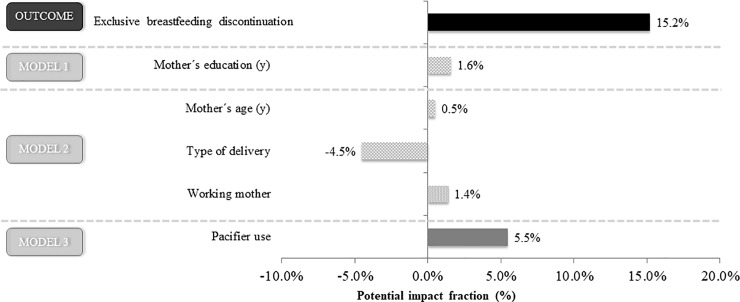
Relative participation (%) in the decrease of exclusive breastfeeding discontinuation in the period 1999–2008: The role of pacifier use.